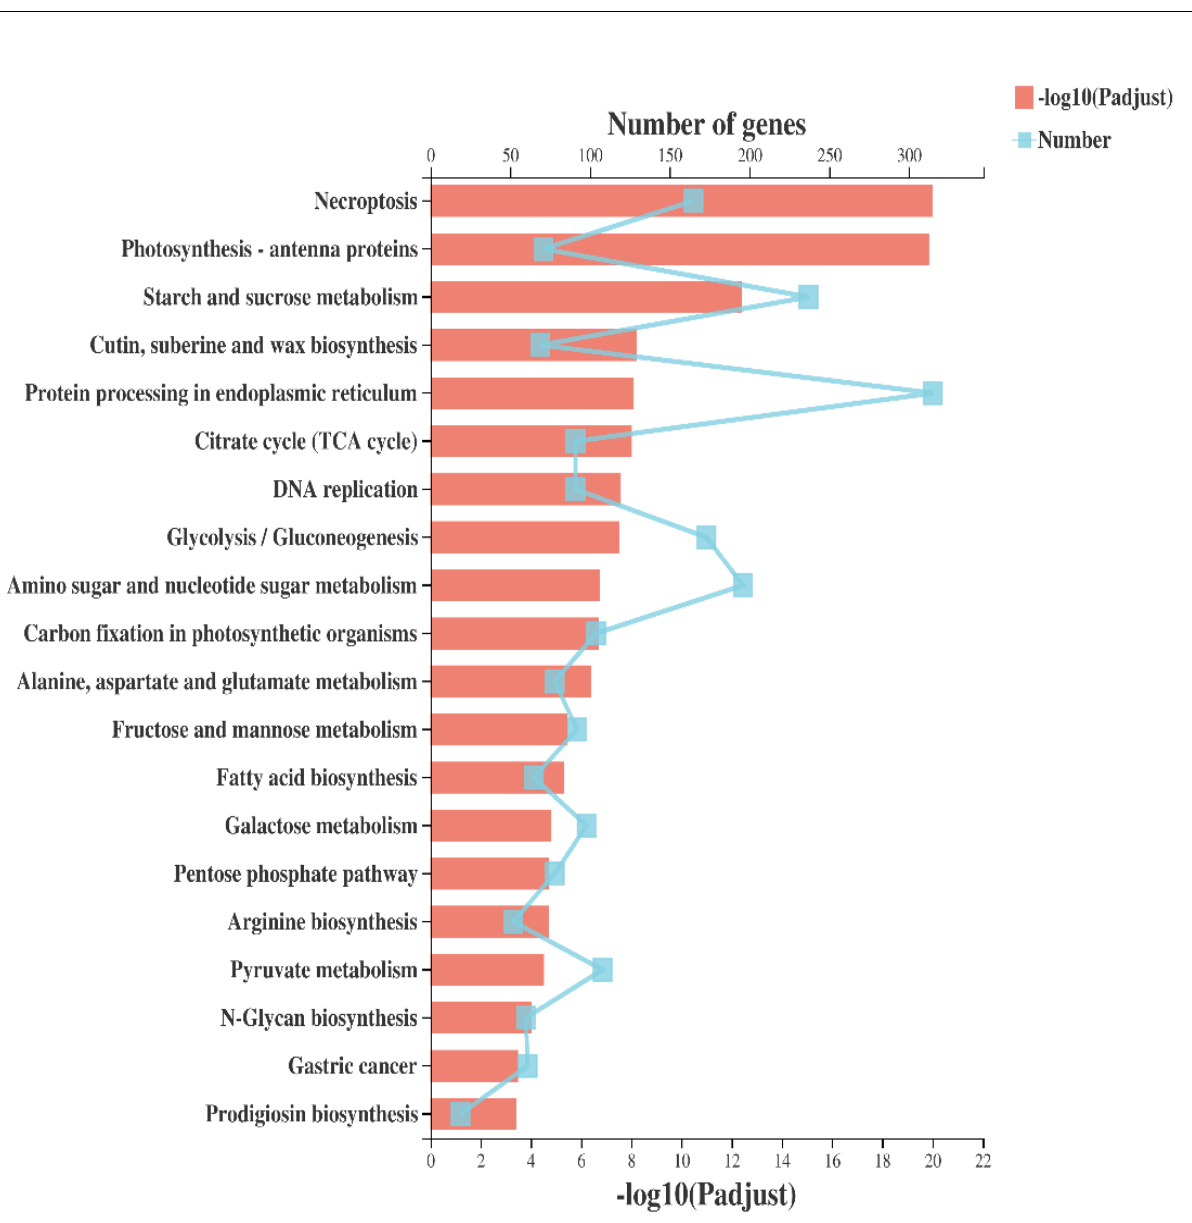
Figure 5. KEGG pathway enrichment analysis for 127 candidate genes. The x-axis shows the gene ratio; the y-axis corresponds to KEGG pathways. The dot color represents the corrected P value of <0.05, and the dot size represents the number of genes enriched in the reference pathway. The protein processing in endoplasmic reticulum, starch and sucrose metabolism, amino sugar and nucleotide sugar metabolism, glycolysis/gluconeogenesis, necroptosis, and pyruvate metabolism was significantly enriched, detail given in Supplementary File S1, sheet 1.